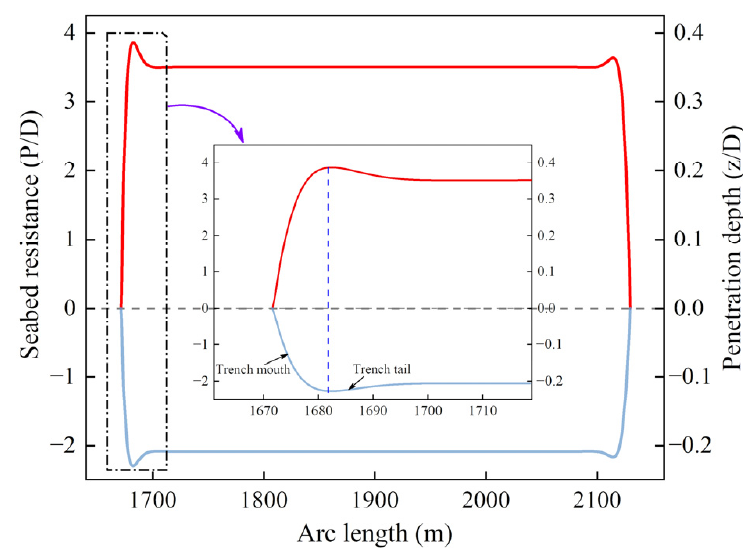
Figure 16. Distribution of bending moment.